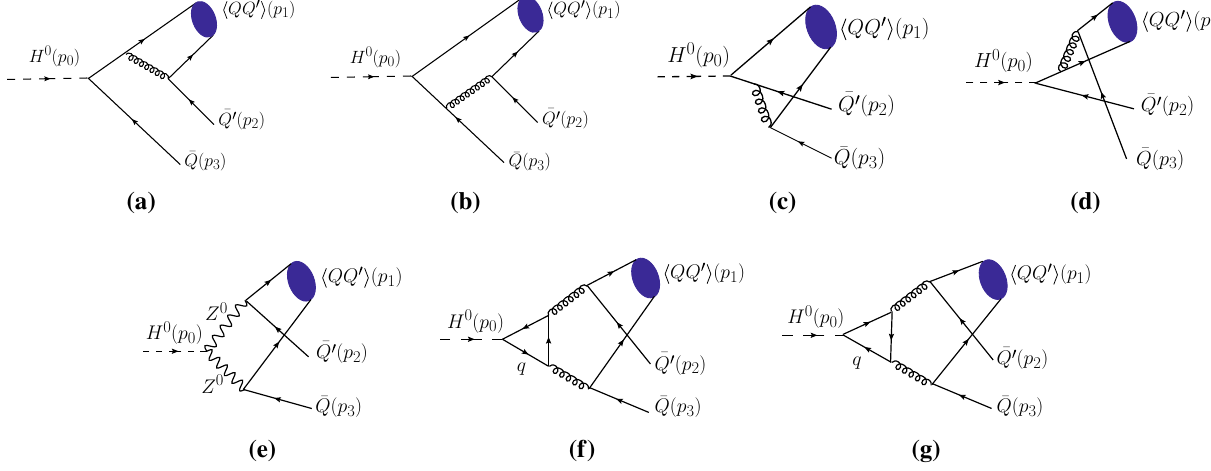
Fig. 1 Typical Feynman diagrams for the process H 0 ( p 0 ) → Q ¯ Q / Q (cid:3) ¯ Q (cid:3) / Z 0 Z 0 / gg → (cid:2) QQ (cid:3) ( p 1 ) + ¯ Q (cid:3) ( p 2 ) + ¯ Q ( p 3 ) , where Q and Q (cid:3) denote the heavy c and b